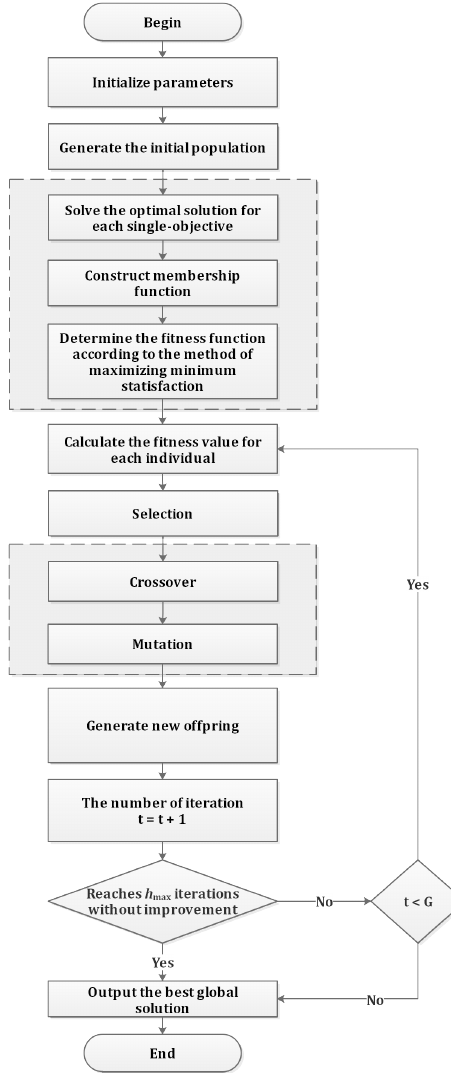
Figure 3. Flow chart of our proposed FGGA